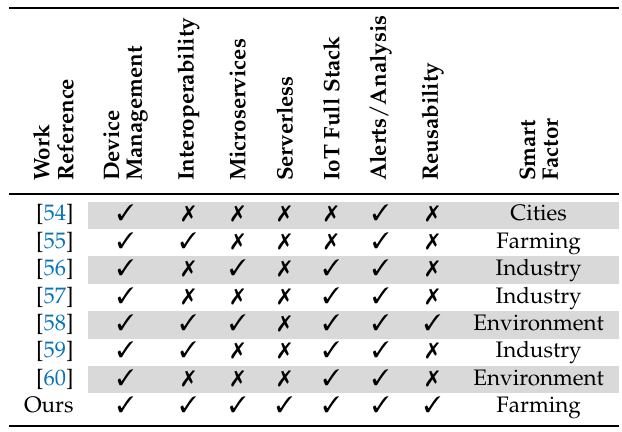
Table 3. Comparison between different related